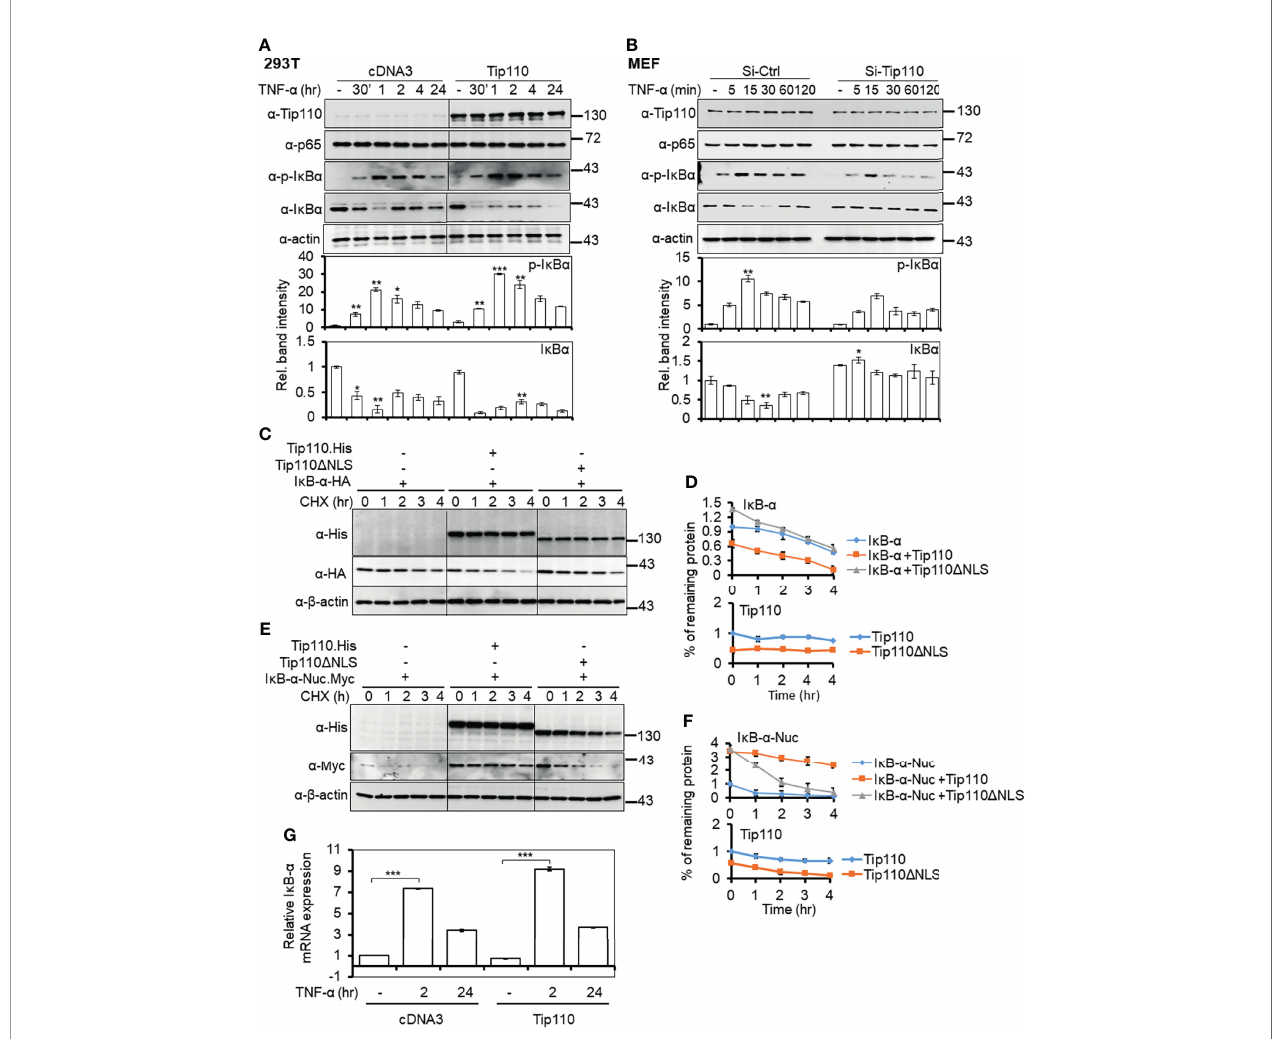
FIGURE 4 | Effects of Tip110 expression on I k B a phosphorylation and protein stability. (A) 293T were transfected with Tip110.His and its plasmid control, treated with 20 ng/ml of TNF- a for 0, 30 min, 1, 2 4 and 24 hr then harvested for Western blotting. pcDNA3 was used to equalize the total amount of DNA among the transfection. (B) Primary mouse embryonic fi broblasts (MEF) were transfected with 50 nM Si-Ctrl or Si-Tip110, cultured for 24 hr, treated with 20 ng/ml TNF- a for 0, 5, 15, 30, 60, or 120 min. 293T were transfected with (C) I k B a .HA or (E) I k B a .Nuc.Myc and Tip110.His or Tip110 D NLS.His, cultured for 48 hr, treated with 20 µg/ ml cycloheximide (CHX) for 0, 1, 2, 3, and 4 hr, and then harvested for Western blotting. Relative I k B a protein level was normalized to b -actin and expressed as a percentage of the untreated or as individual values (D, F) . (G) 293T were transfected with Tip110 or pcDNA3, cultured for 48 hr, treated with TNF- a (10 ng/ml) for 2 or 24 hr, and harvested for total RNA isolation and qRT-PCR for I k B a mRNA level. Relative I k B a mRNA was normalized to b -actin and calculated using the untreated as a reference. *P<0.05, **P<0.01,